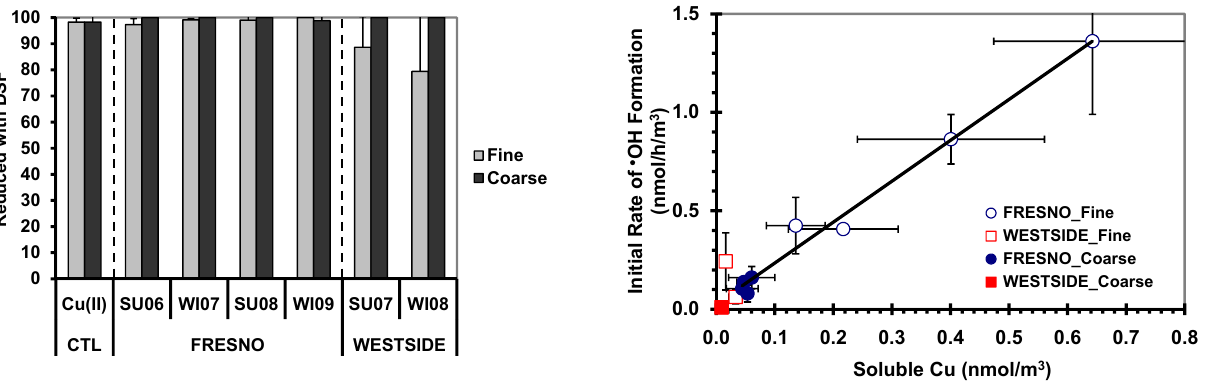
Fig. 8. Correlation between the air-volume-normalized initial rate of • OH generation in SLF with Asc and the accompanying SLF- Figure 8 soluble Cu concentration. Values are means ± SD. n = 6 except for a few of the Cu concentrations where n = 4. The initial rates of • OH formation by Fresno fine and coarse PM were strongly corre- lated with the SLF-soluble Cu concentrations in corresponding PM extracts: y = 2 . 08 x + 0 . 03, R 2 = 0 . 98. No correlation was observed between the SLF-soluble Cu concentrations and the initial rates of • OH formation from the Westside PM ( R 2 = 0 .